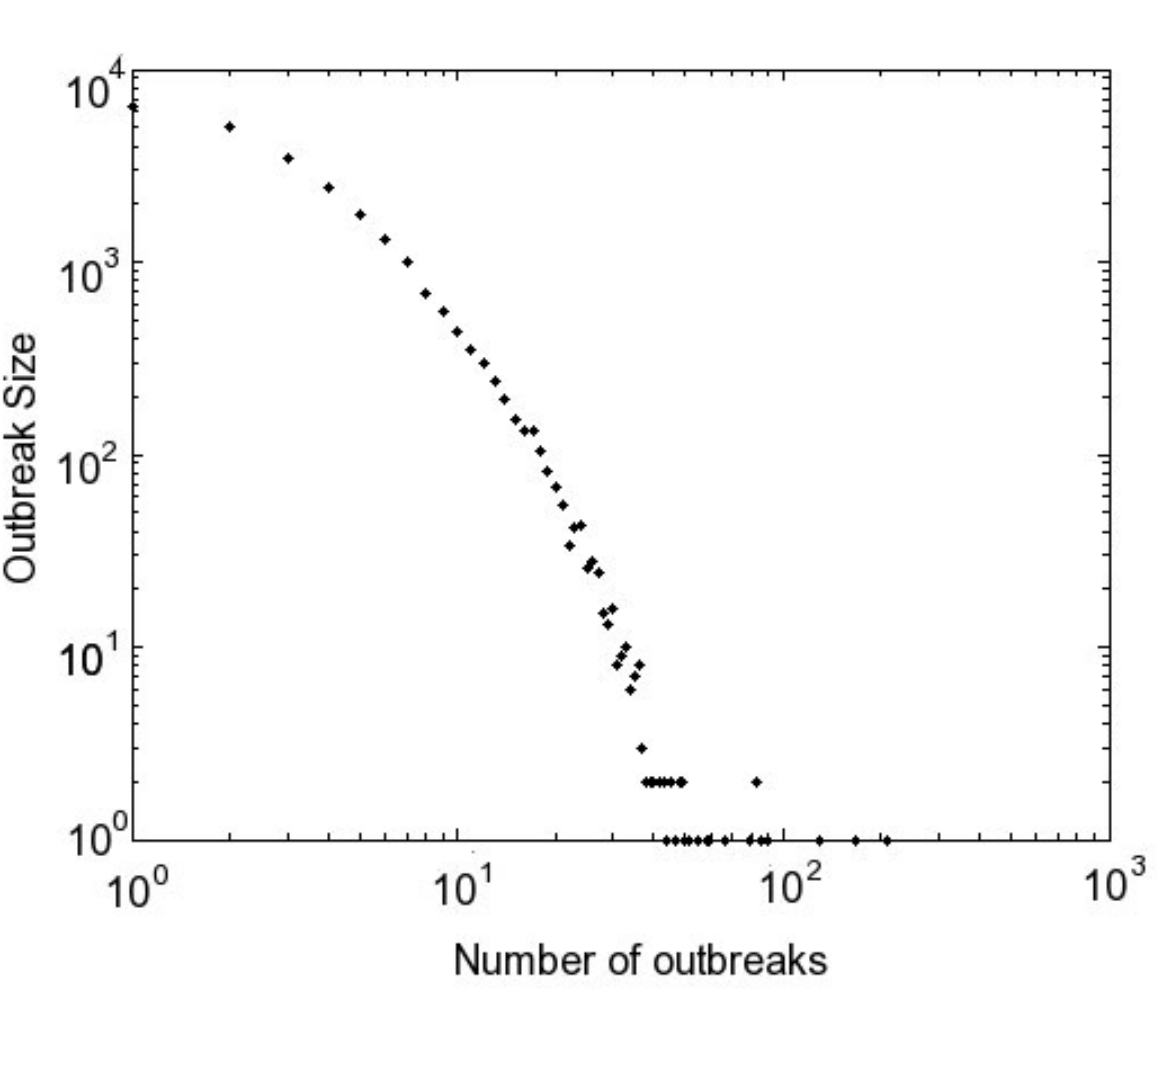
Fig. 4. The frequency distribution of the size of outbreaks from the population model over 50 000